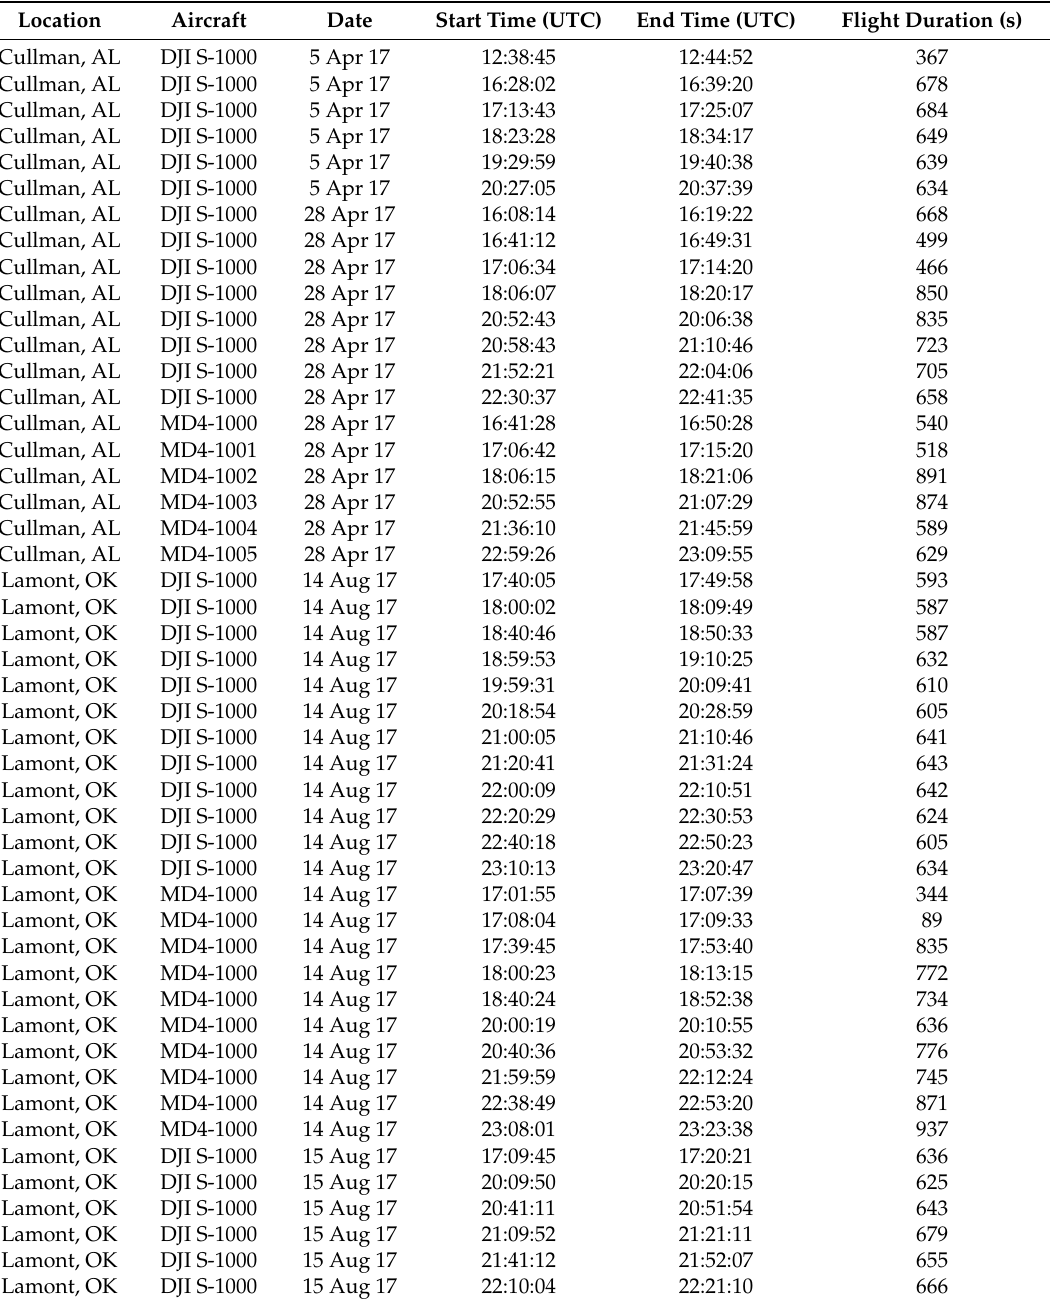
Table 2. sUAS flights used in the present study. Note that, at both sites, local time =